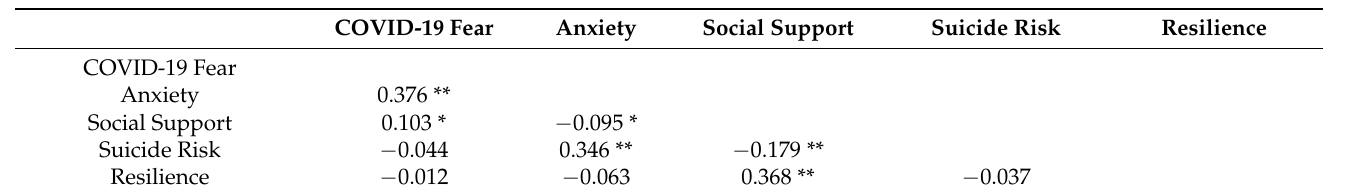
Table 3. Correlations among scales.